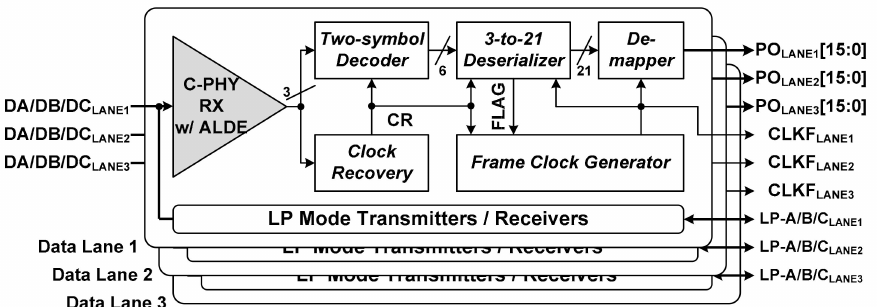
Figure 7. Block diagram of proposed MIPI C-PHY receiver